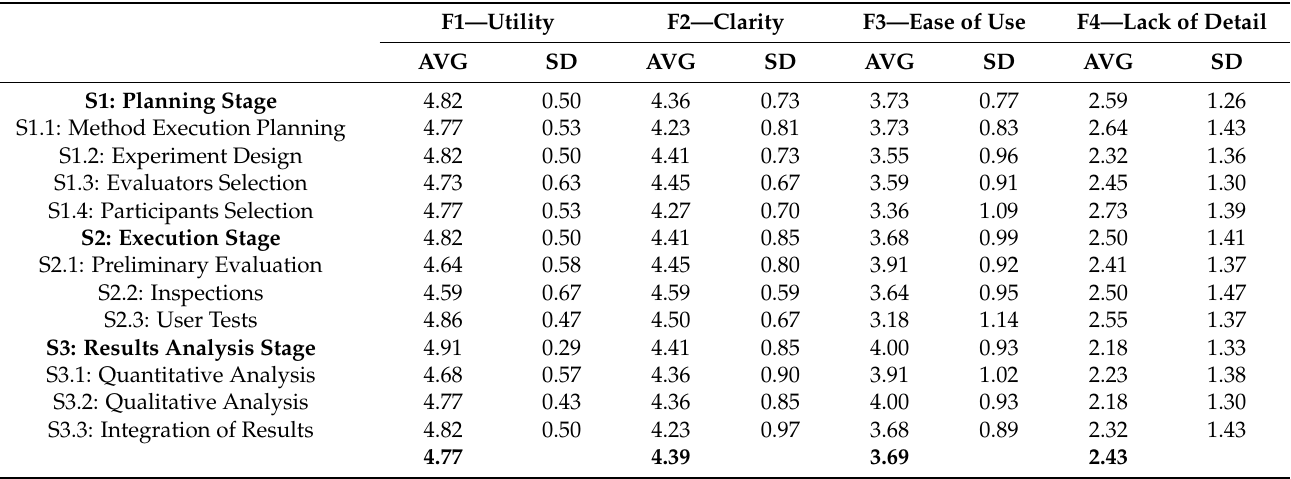
Table 1. Results for factors F1, F2, F3 and